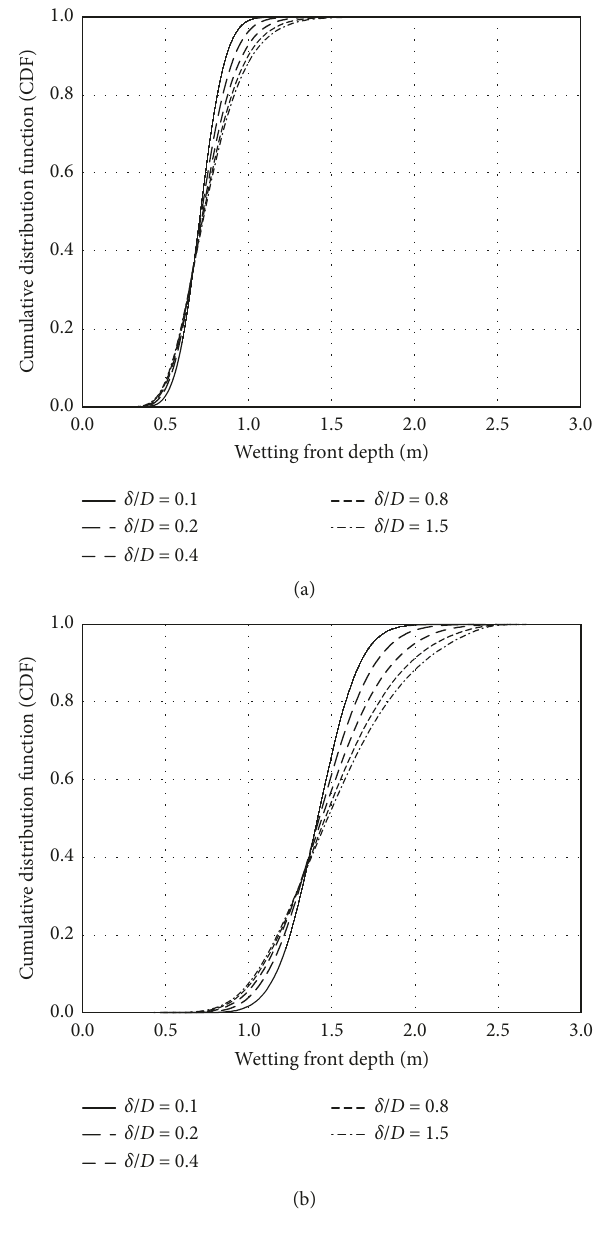
Figure 11: Distribution of WFD according to normalized SOF for rainfall duration of (a) 6 hours and (b) 18